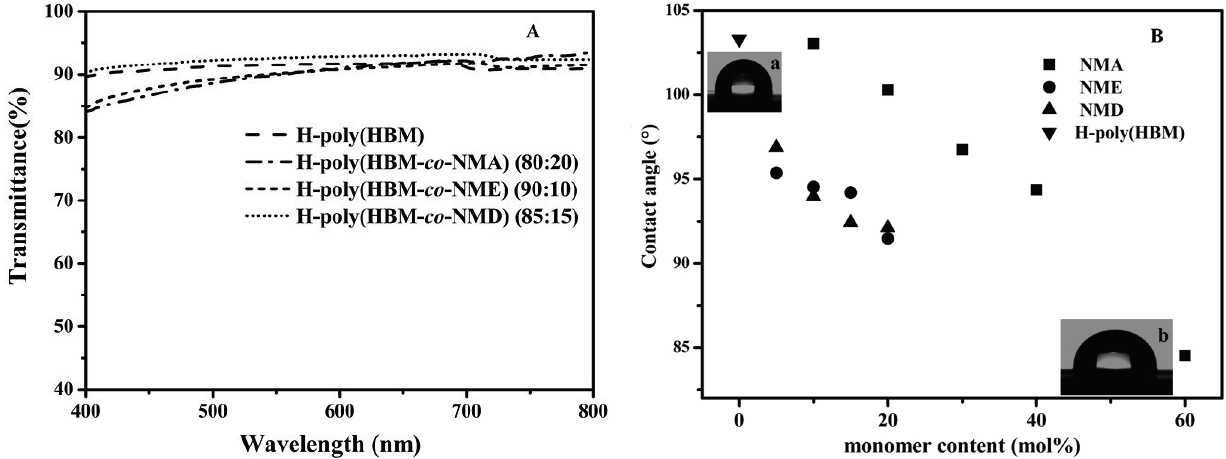
Figure 3. ( A ) Transparency of self-standing COPs films and ( B ) the water contact angle of copolymers (a, H-poly(HBM); b, H-poly(HBM- co -NMA)